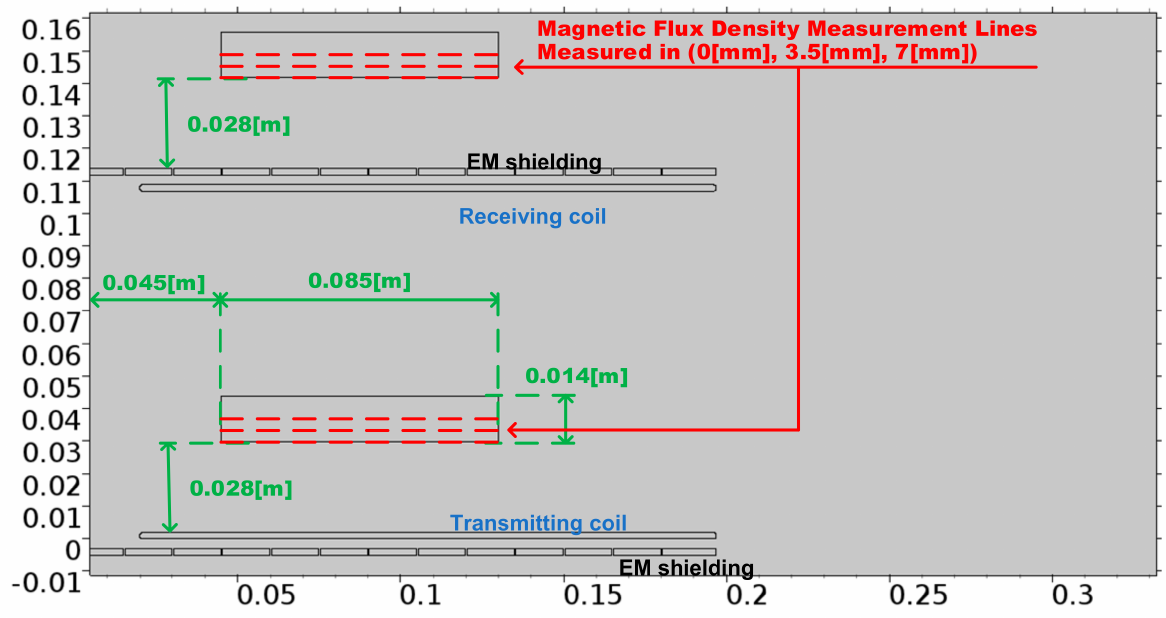
Figure 6. The scheme of the biological samples location in the WPT system during exposure.